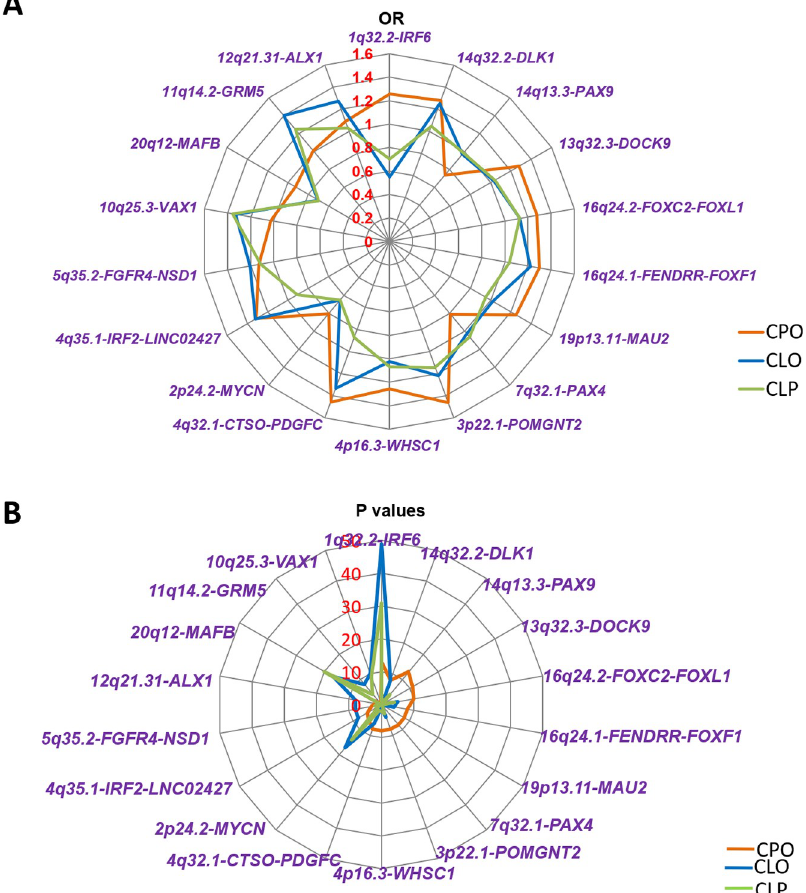
Fig 4. The contribution analysis of associated genes/loci identified in this study for subtypes of NSOFC. TFs were colored in dark pink and other genes were colored in black. The values of the picture were the ORs (A) and the − log 10 P values (B) of the meta results of the most significant SNP of that gene (adjusted for sample size). The genetic association patterns of CLO and CLP were much more similar when compared with that of CPO (C) . Some genes/loci were more specific to